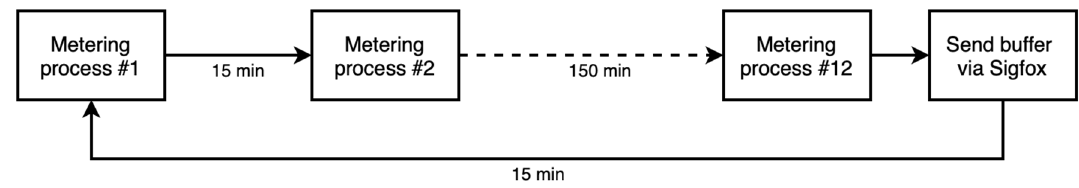
Figure 15. Graphical representation of the standard metering cycle.